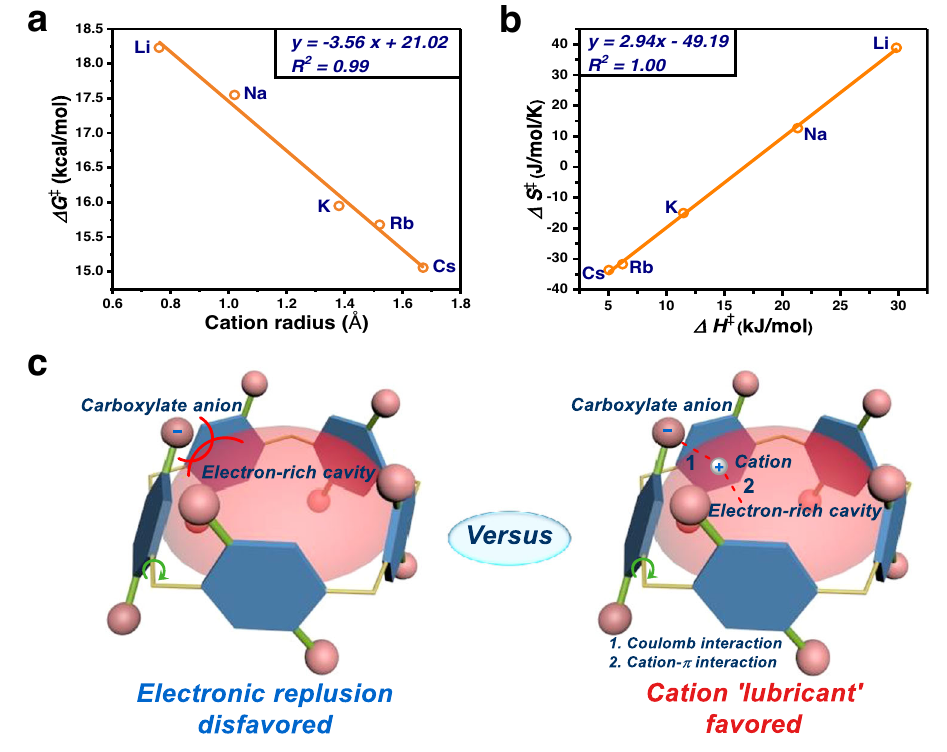
Fig. 4 | Kinetic analysis of rotations in WP5-M. a Correlation of the rotational barrier Δ G ≠ exp withcorrespondingcationradius. b Enthalpy-entropycompensation plot of WP5-M . c Illustration of electron repulsion between carboxylate anion